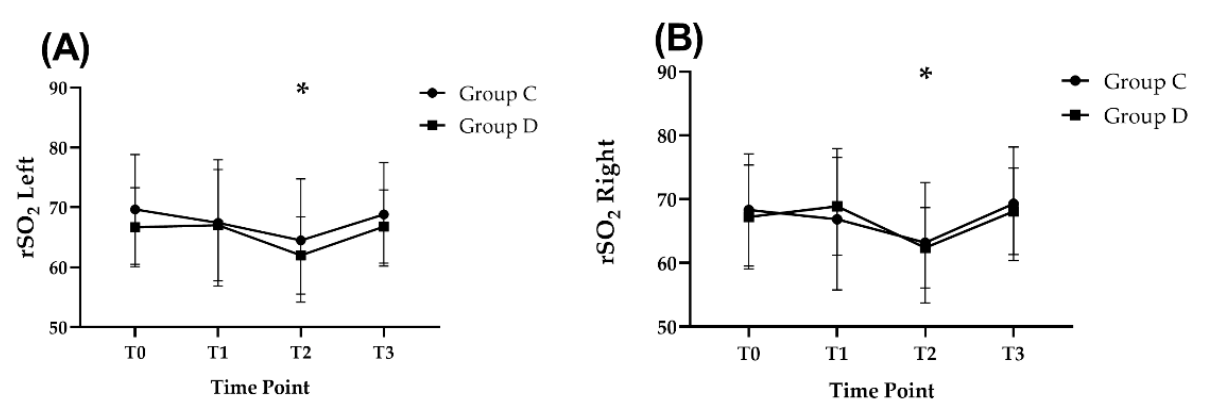
Figure 3. Change in heart rate during the study period. Error bars represent standard deviation. * p < 0.05 vs. T0, † p < 0.05 vs. Group C. T0, before anesthetic induction; T1, 10 min after anesthetic induction; T2, 60 min after changing to beach chair position; and T3, 10 min after having returned to a supine position.